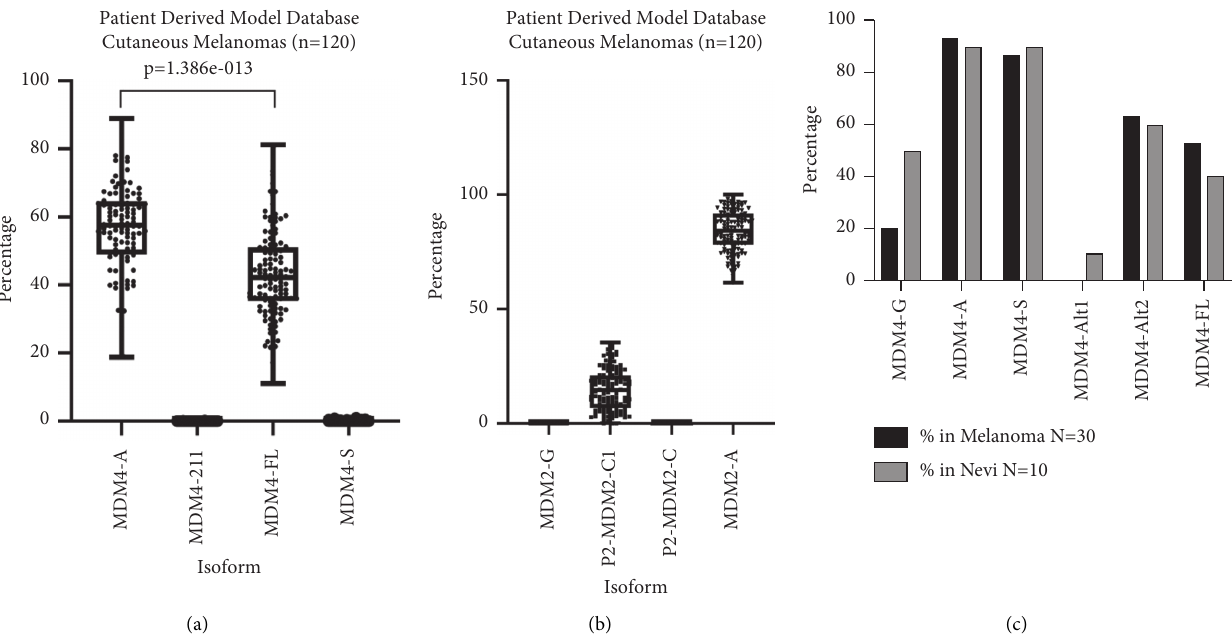
Figure 5: MDM4 isoform expression in melanocytic lesions is dramatically different from normal skin. Isoform-specific expression data were compared for 120 patient-derived xenografts. (a) Expression of the alternative transcript MDM4-A is significantly greater than the expression of the full-length MDM4 transcript in these specimens (Students’ t -test p value � 1.386 × 10 − 13 ). (b) In contrast, MDM2 ex- pression is almost entirely the full-length transcript designated as MDM2-A. (c) Analysis of 30 clinical melanoma specimens and 10 melanocytic benign nevi by isoform-specific RT-PCR.